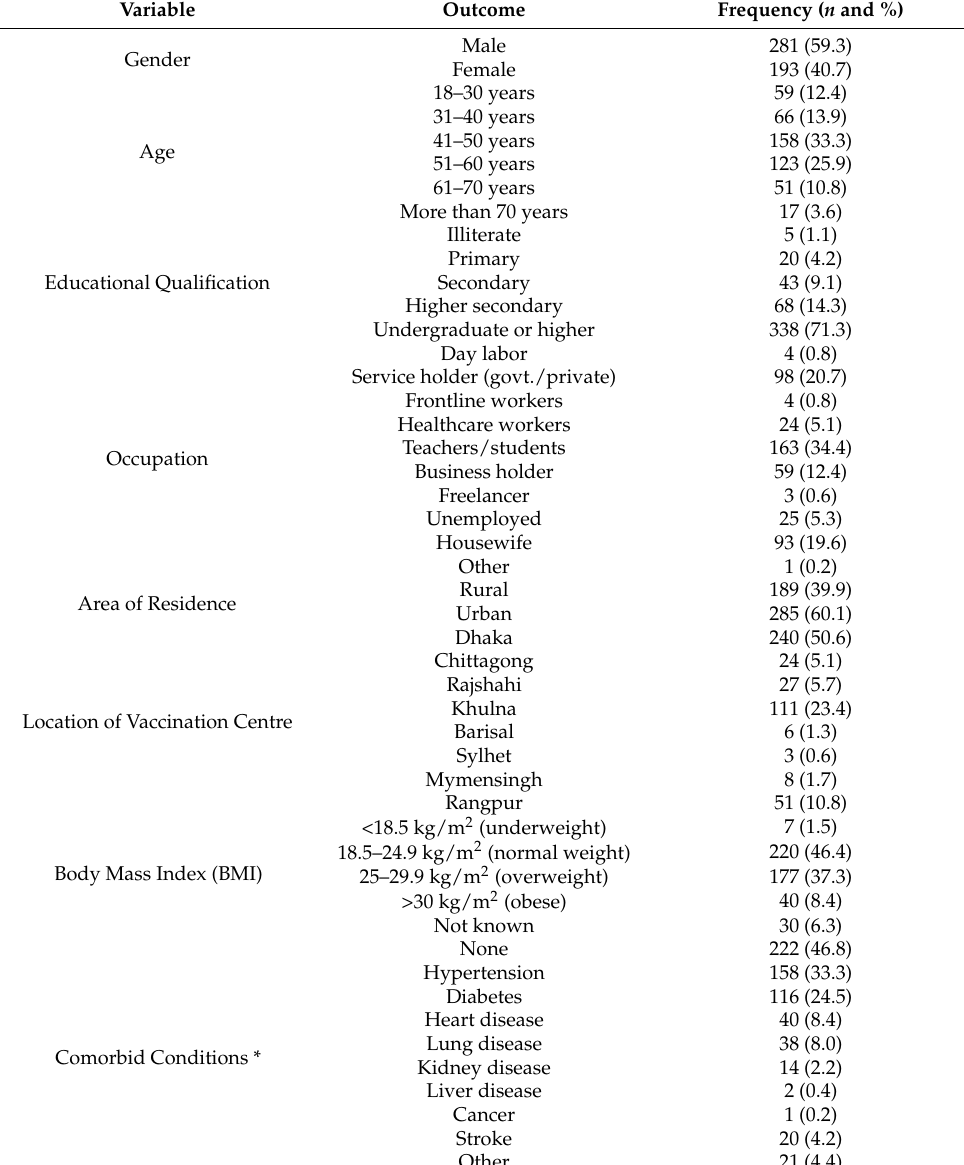
Table 1. Demographic characteristics of study participants ( n =